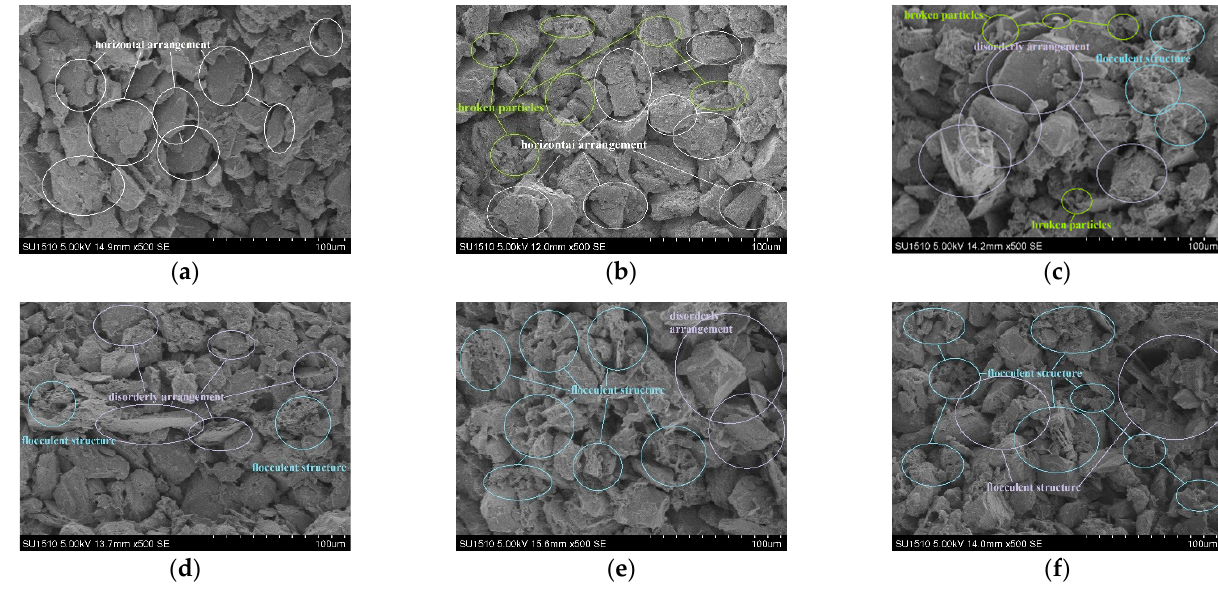
Figure 7. The SEM images of silt under different freeze–thaw cycles. ( a ) Unfrozen; ( b ) freeze–thaw 10 times; ( c ) freeze–thaw 20 times; ( d ) freeze–thaw 30 times; ( e ) freeze–thaw 50 times; ( f ) freeze–thaw 100 times.